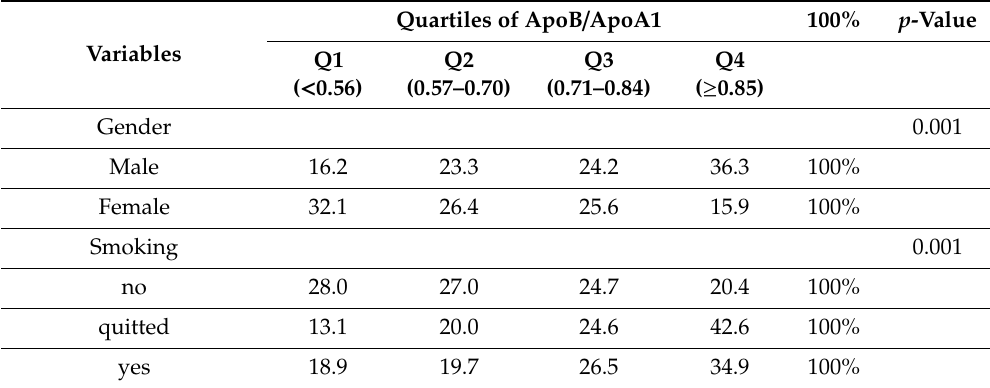
Table 2. Characteristics across quartiles of ApoB / apoA1